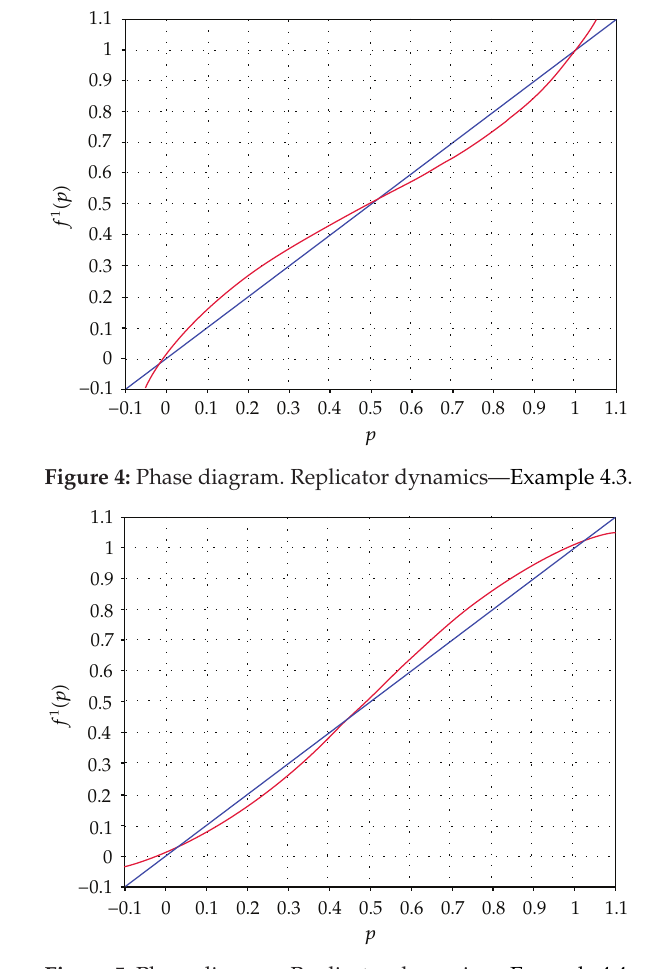
Figure 5: Phase diagram. Replicator dynamics—Example